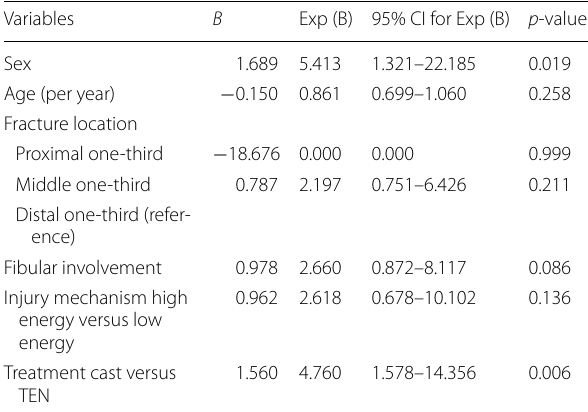
Table 6 Risk factors for overgrowth ( shaft fracture